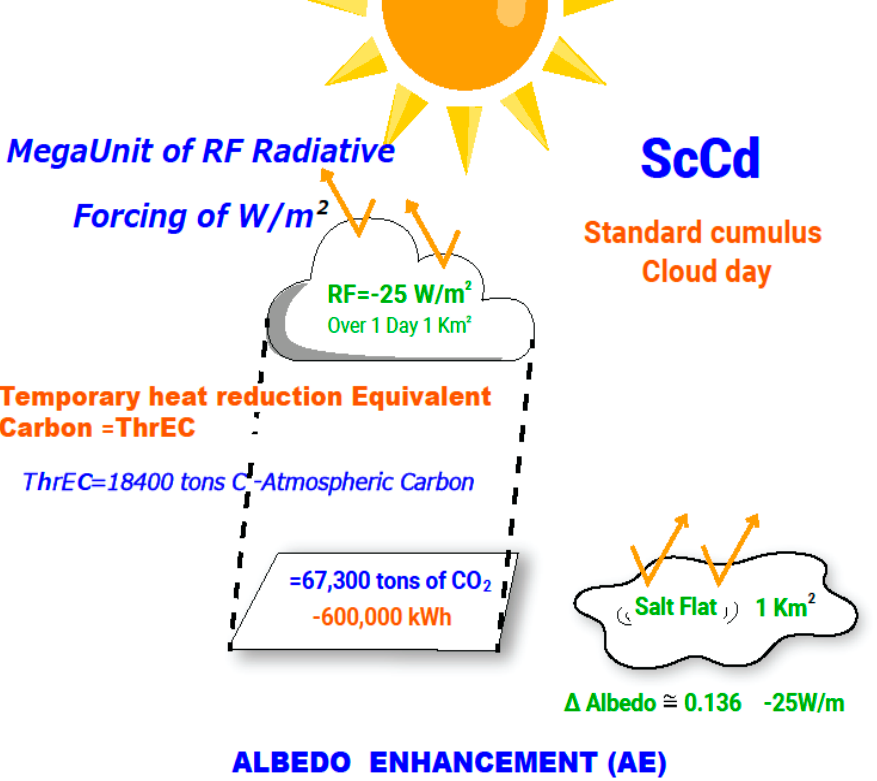
Figure 1. Albedo enhancement (AE) by cloud or by land, such as salt flat rejuvenation. The ScCd cooling effect results in ThrEC and an approximate delta albedo (see Section 1.2 for calculations).